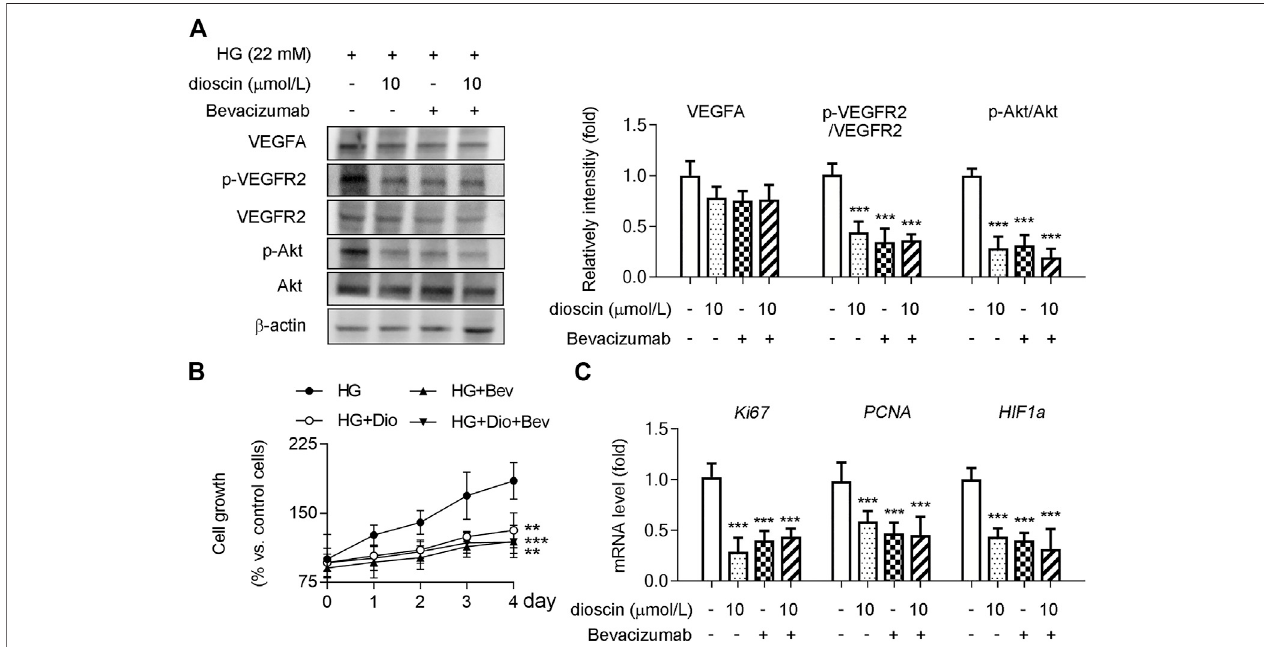
FIGURE 4 | Dioscin regulates the VEGFA – VEGFR2 signaling pathway. HRMECs treated with dioscin and/or bevacizumab as indicated in panel A. (A) Protein level of VEGFA, p-VEGFR2, VEGFR2, p-Akt, and Akt was detected by Western blot, and the quantitative results were shown in the right panel, n (cid:1) 3. (B) Cell growth of HRMECs wasassessed usingaCCK-8 assay, n (cid:1) 3. (C) MRNAlevels of Ki67, PCNA ,and HIF1 α weredetermined byqPCR, n (cid:1) 5.*** p < 0.001 vs.thecontrolgroupby one-way ANOVA with Bonferroni correction.